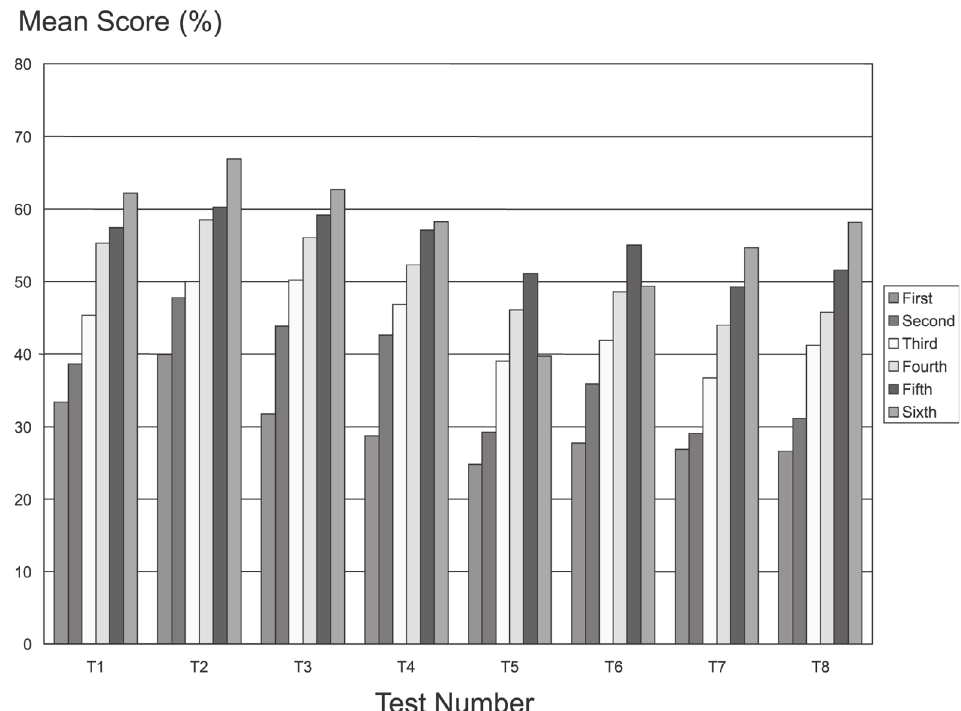
Figure 1 - Mean scores for all questions, for students from first to sixth year* according to occasion on which the test was applied (tests 1-8) (for all tests, P for trend < .0001). *For each sequence of columns, the first represents first-year students; the second, second-year students; the third, third-year students; the fourth, fourth-year students; the fifth, fifth-year students; and the sixth, sixth-year